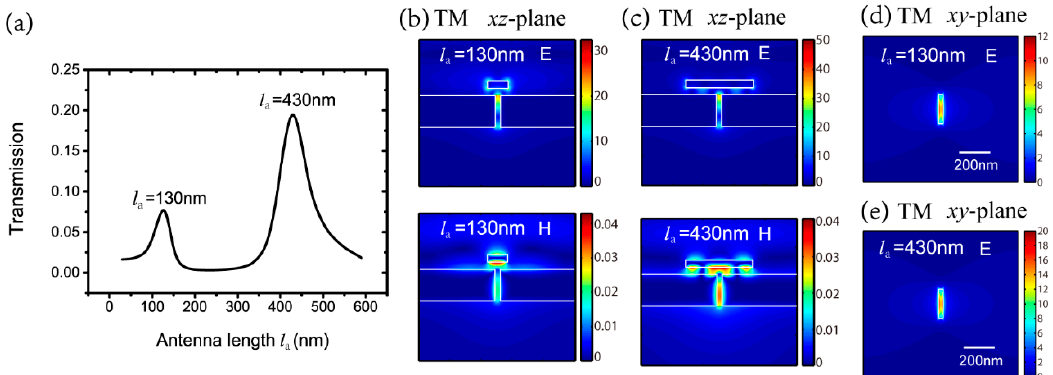
Figure 2. ( a ) Transmission with various antenna lengths of l a for transverse magnetic (TM) polarization; electric and magnetic field distributions of ( b ) l a = 130 nm and ( c ) l a = 430 nm for TM polarization in the xz section; electric field distributions of ( d ) l a = 130 nm and ( e ) l a = 430 nm for TM polarization at the aperture export.